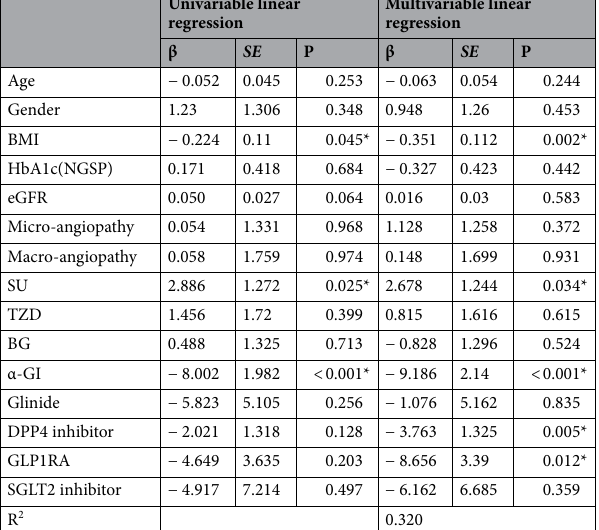
High dose SU group (n = 10)